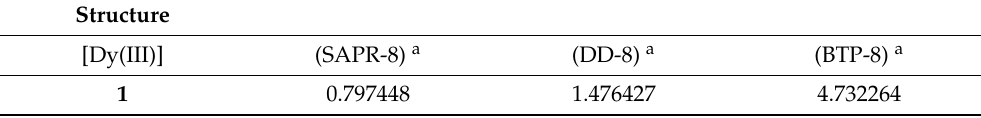
Table 3. SHAPE analyses of Dy(III) in 1 .